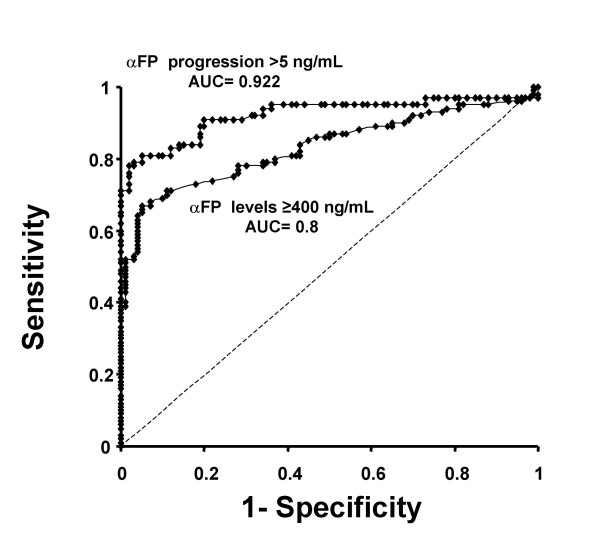
ROC curve for the progressive elevation of αFP and αFP levels. The area under the curve for the progressive elevation of αFP is significantly greater than the area under the curve for αFP levels (p < 0.05). (AUC = Area Under the Curve).